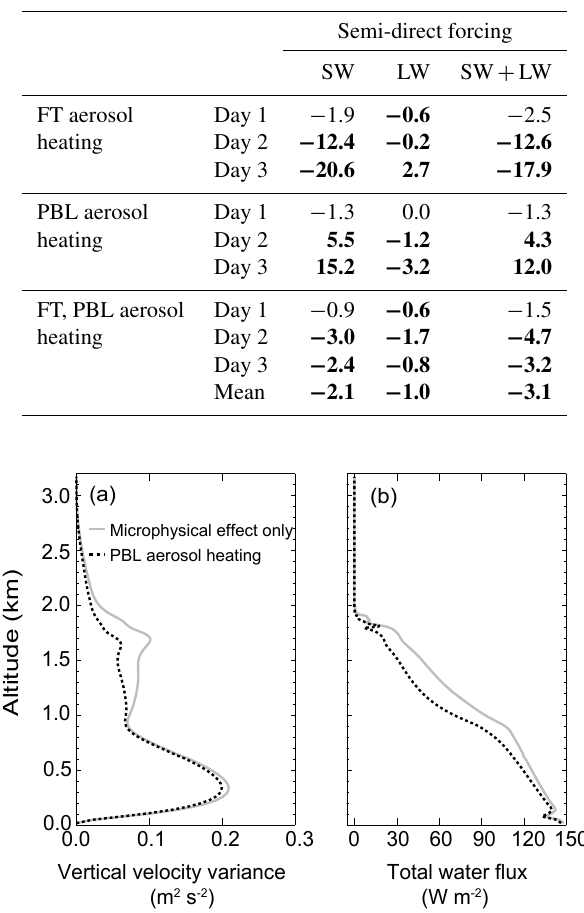
Table 6. Semi-direct forcing of absorbing aerosol, computed as the diurnal-average difference in radiative fluxes at TOA (in Wm − 2 ) of simulations with aerosol heating restricted to the FT and PBL, or not restricted relative to the simulation without aerosol heating. All simulations allow the absorbing aerosol to act as CCN. Boldface indicates results exceeding the uncertainty range derived from the spread of the lightly drizzling baseline ensemble.